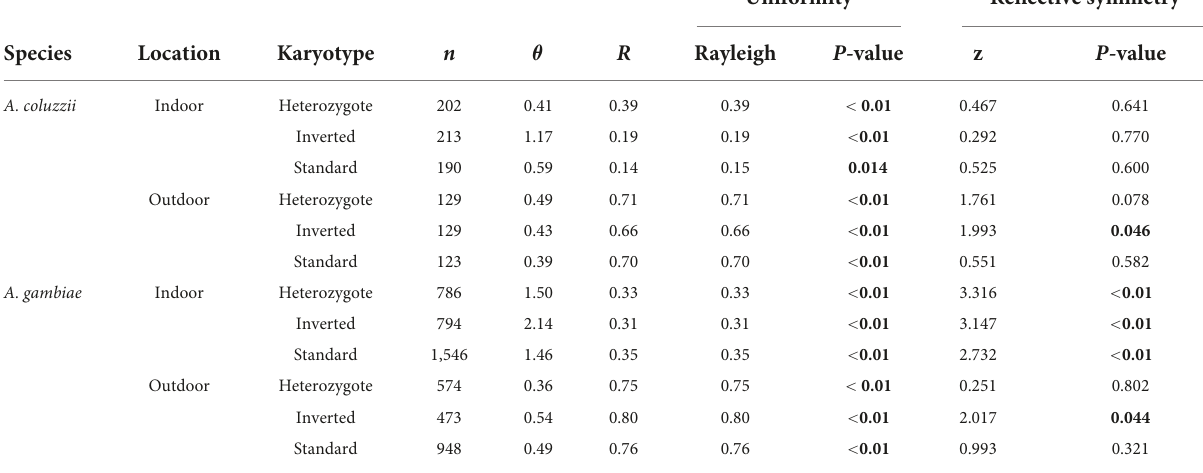
Uniformity Reflective symmetry